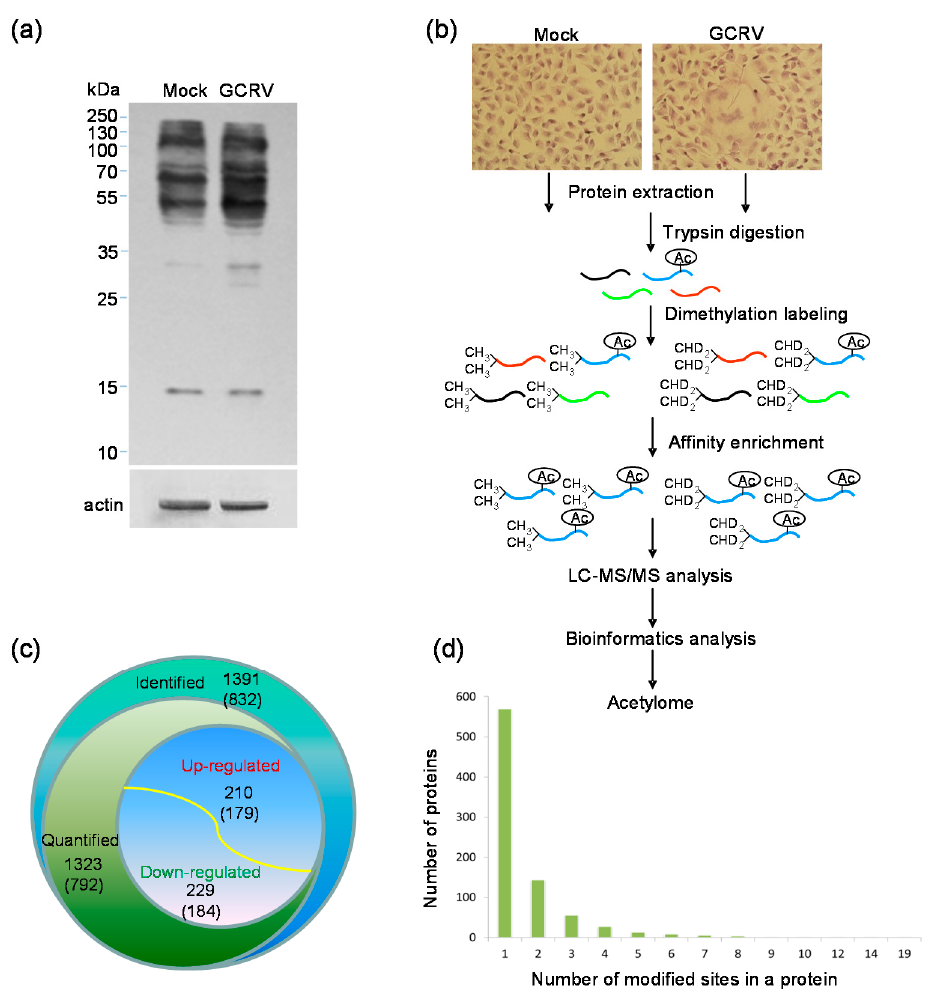
Figure 1. Proteome-wide identification of lysine acetylation sites and proteins in CIK cells in response to grass carp reovirus (GCRV) infection. ( a ) Lysine acetylation in GCRV infected or mock-infected cells as analyzed by Western blotting, β -actin was used as loading control; ( b ) Experimental strategy used to identify and quantify acetylated lysine sites in CIK cells in response to GCRV infection; ( c ) Number of identified and quantified lysine acetylated sites and proteins. The up-regulated and down-regulated sites and proteins were also indicated. The number of proteins was shown in brackets; ( d ) Distribution of acetylated proteins based on their number of lysine acetylation sites.